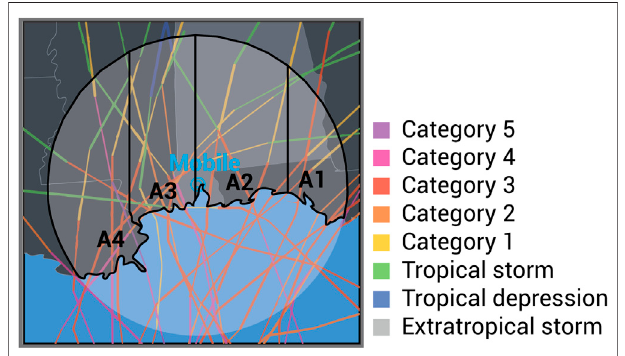
FIGURE 2 | Historical hurricane tracks of Category 3-5 hurricanes (1851 – 2019): data from NOAA (2020).